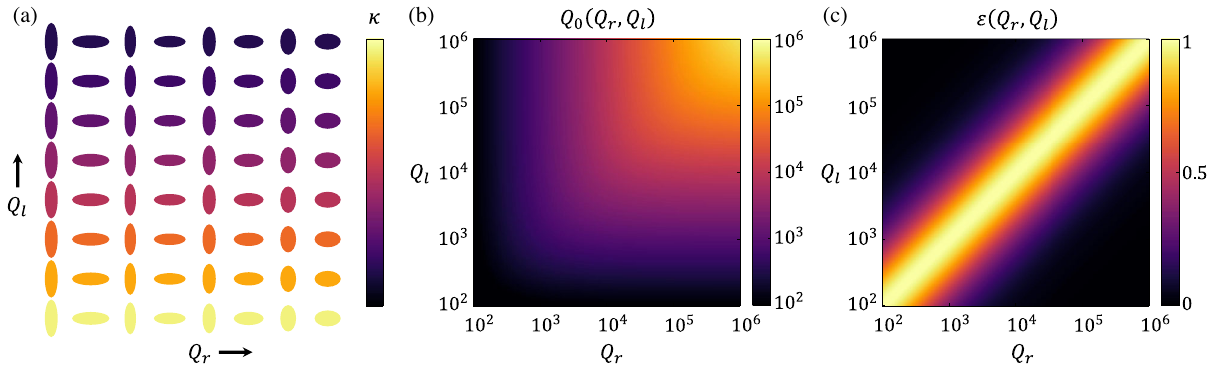
FIG. 10. Controlling spectral linewidth and peak emissivity with a doped photonic crystal slab. (a) Library of metaunits varying the ∝ 1 = κ and perturbation magnitude δ to control the dopant concentration (extinction coefficient κ ) to control the nonradiative Q factor Q l ∝ 1 = δ 2 for x -polarized light. (b) Fano resonance Q factor Q radiative Q factor Q 0 as a function of Q l and Q r . (c) Peak emissivity of r the quasimonochromatic thermal source, as a function of Q and Q l r